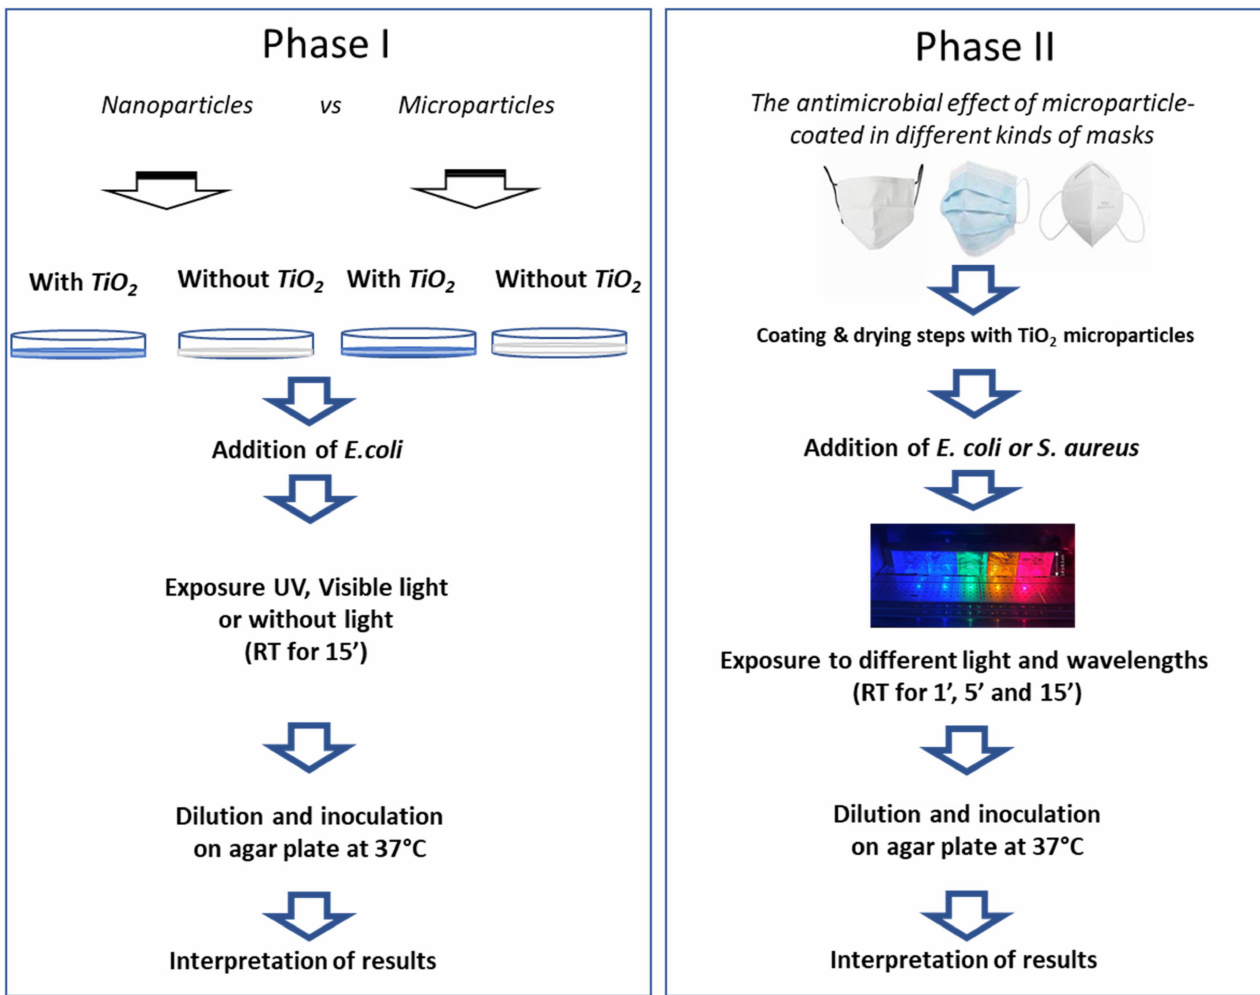
Figure 1. Experimental set-up. The study involved two main steps: ( I ) preliminary investigation of antimicrobial effects of microparticles with respect to nanoparticles exposed under several light wavelengths (control was without TiO 2 particles); and ( II ) testing the antimicrobial effects of different microparticle-coated masks (cloth face mask, cloth surgical mask, and FFP2 mask). This flowchart summarizes the approach used to test the antibacterial activity of light on TiO 2 -coated